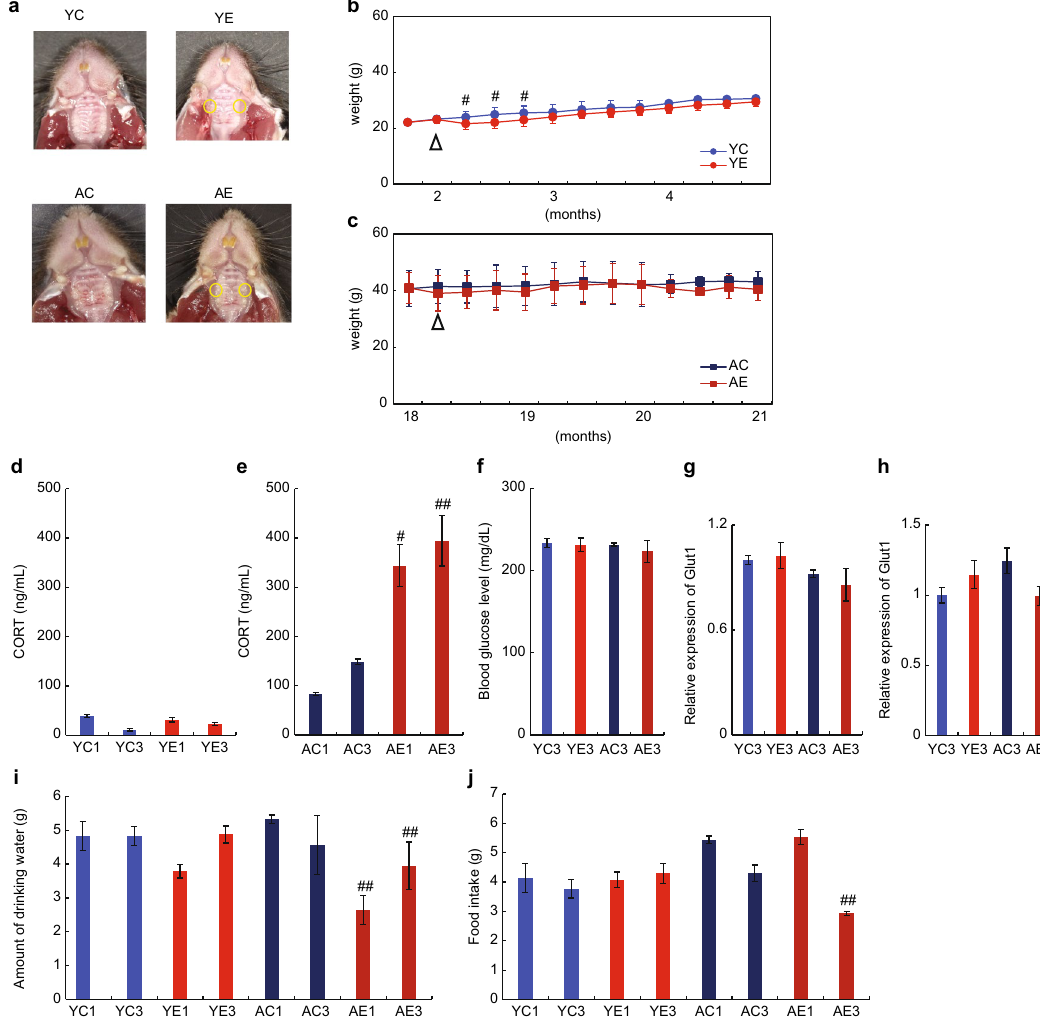
Figure 1. Changes in the weight and stress levels in response to the loss of a maxillary first molar. ( a ) Intraoral photographs of mice after molar extraction. The circled area indicates the extraction socket (1 month after extraction). YC young control group, YE young extraction group, AC aged control group, AE aged extraction group. ( b ) Weight changes in the young group. The vertical axis indicates weight, and the horizontal axis indicates the number of months. The triangular portion indicates the time of molar extraction. ( c ) Weight changes in the aged groups. ( d ) Urinary corticosterone levels in mice from the YC and YE groups (ng/mL). E1 indicates 1 month after molar extraction, and E3 indicates 3 months after molar extraction. ( e ) Urinary corticosterone levels in mice from the AC and AE groups (ng/mL). ( f ) Blood glucose level (mg/dL). ( g ) Expression of Glut1 in the hypothalamus. ( h ) Expression of Glut1 in the hippocampus. Results are presented as means ± SE. YC(E)3 represent young mice groups 3 months after tooth extraction, respectively. The teeth of aged mice were extracted at 18 months of age, AC(E)3 indicates 3 months (21 M) after tooth extraction. ( i ) Amount of drinking water per day (g). ( j ) Amount of food intake per day (g). ## P < 0.01; # P < 0.05 vs. control (Tukey’s post-hoc test). ## P < 0.01; # P < 0.05 vs. control ( t -test). Results are presented as means ±